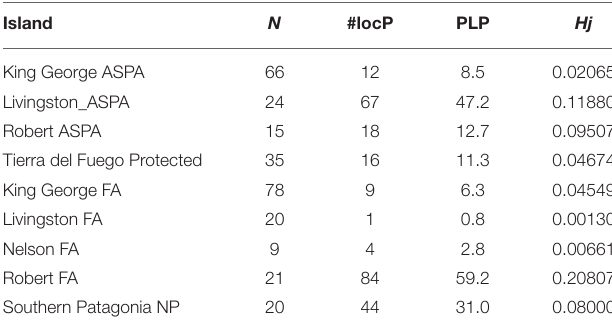
TABLE 2 | Results of genetic diversity among Antarctic Specially Protected Area (ASPA) and free access areas in island